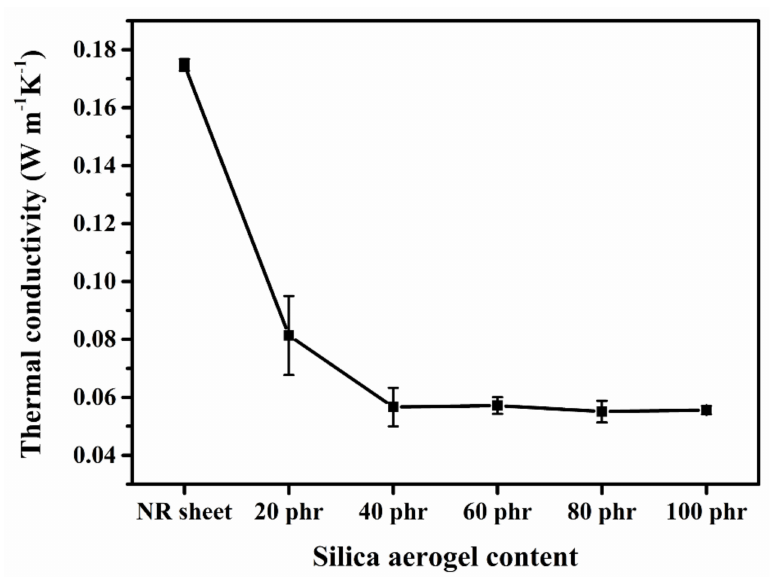
Figure 6. Thermal conductivity of silica aerogel/NR composites in different silica aerogel contents and NR sheet.